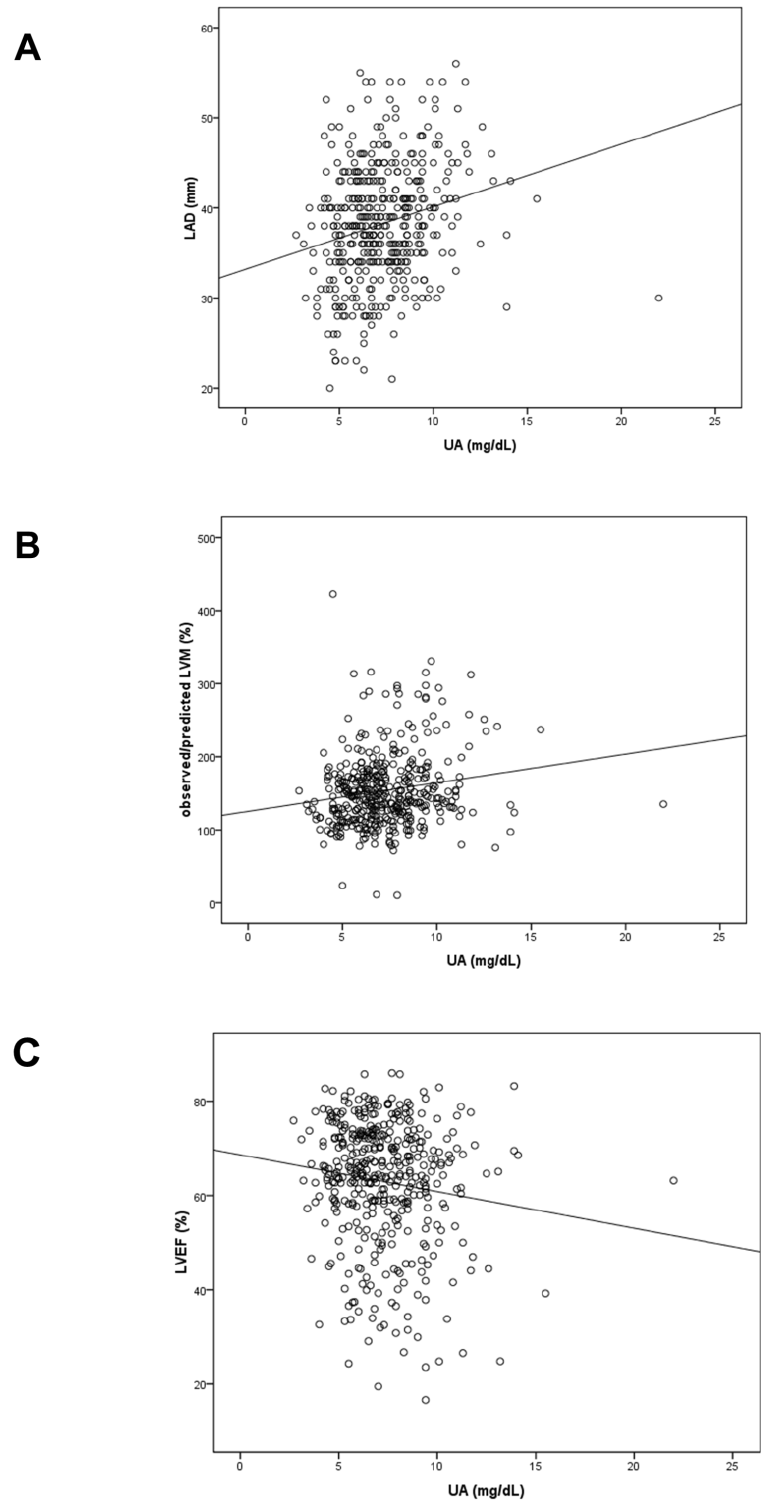
Figure 2. Scatter plots of distribution and correlation of serum UA and LAD ( A ), observed / predicted LVM ( B ) and LVEF ( C ).